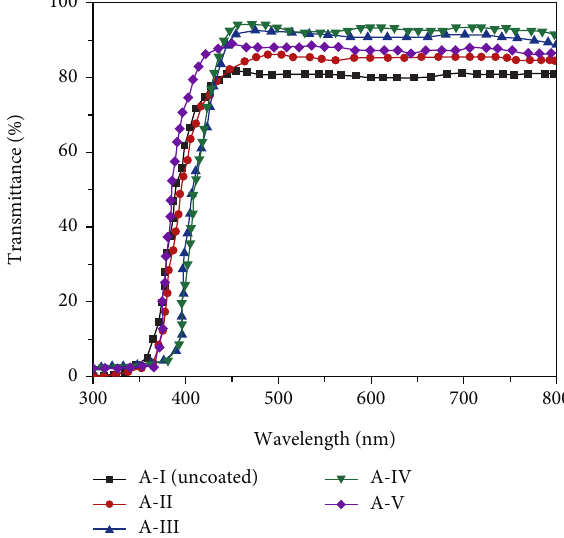
Figure 6: Transmittance of bare cell and MoS